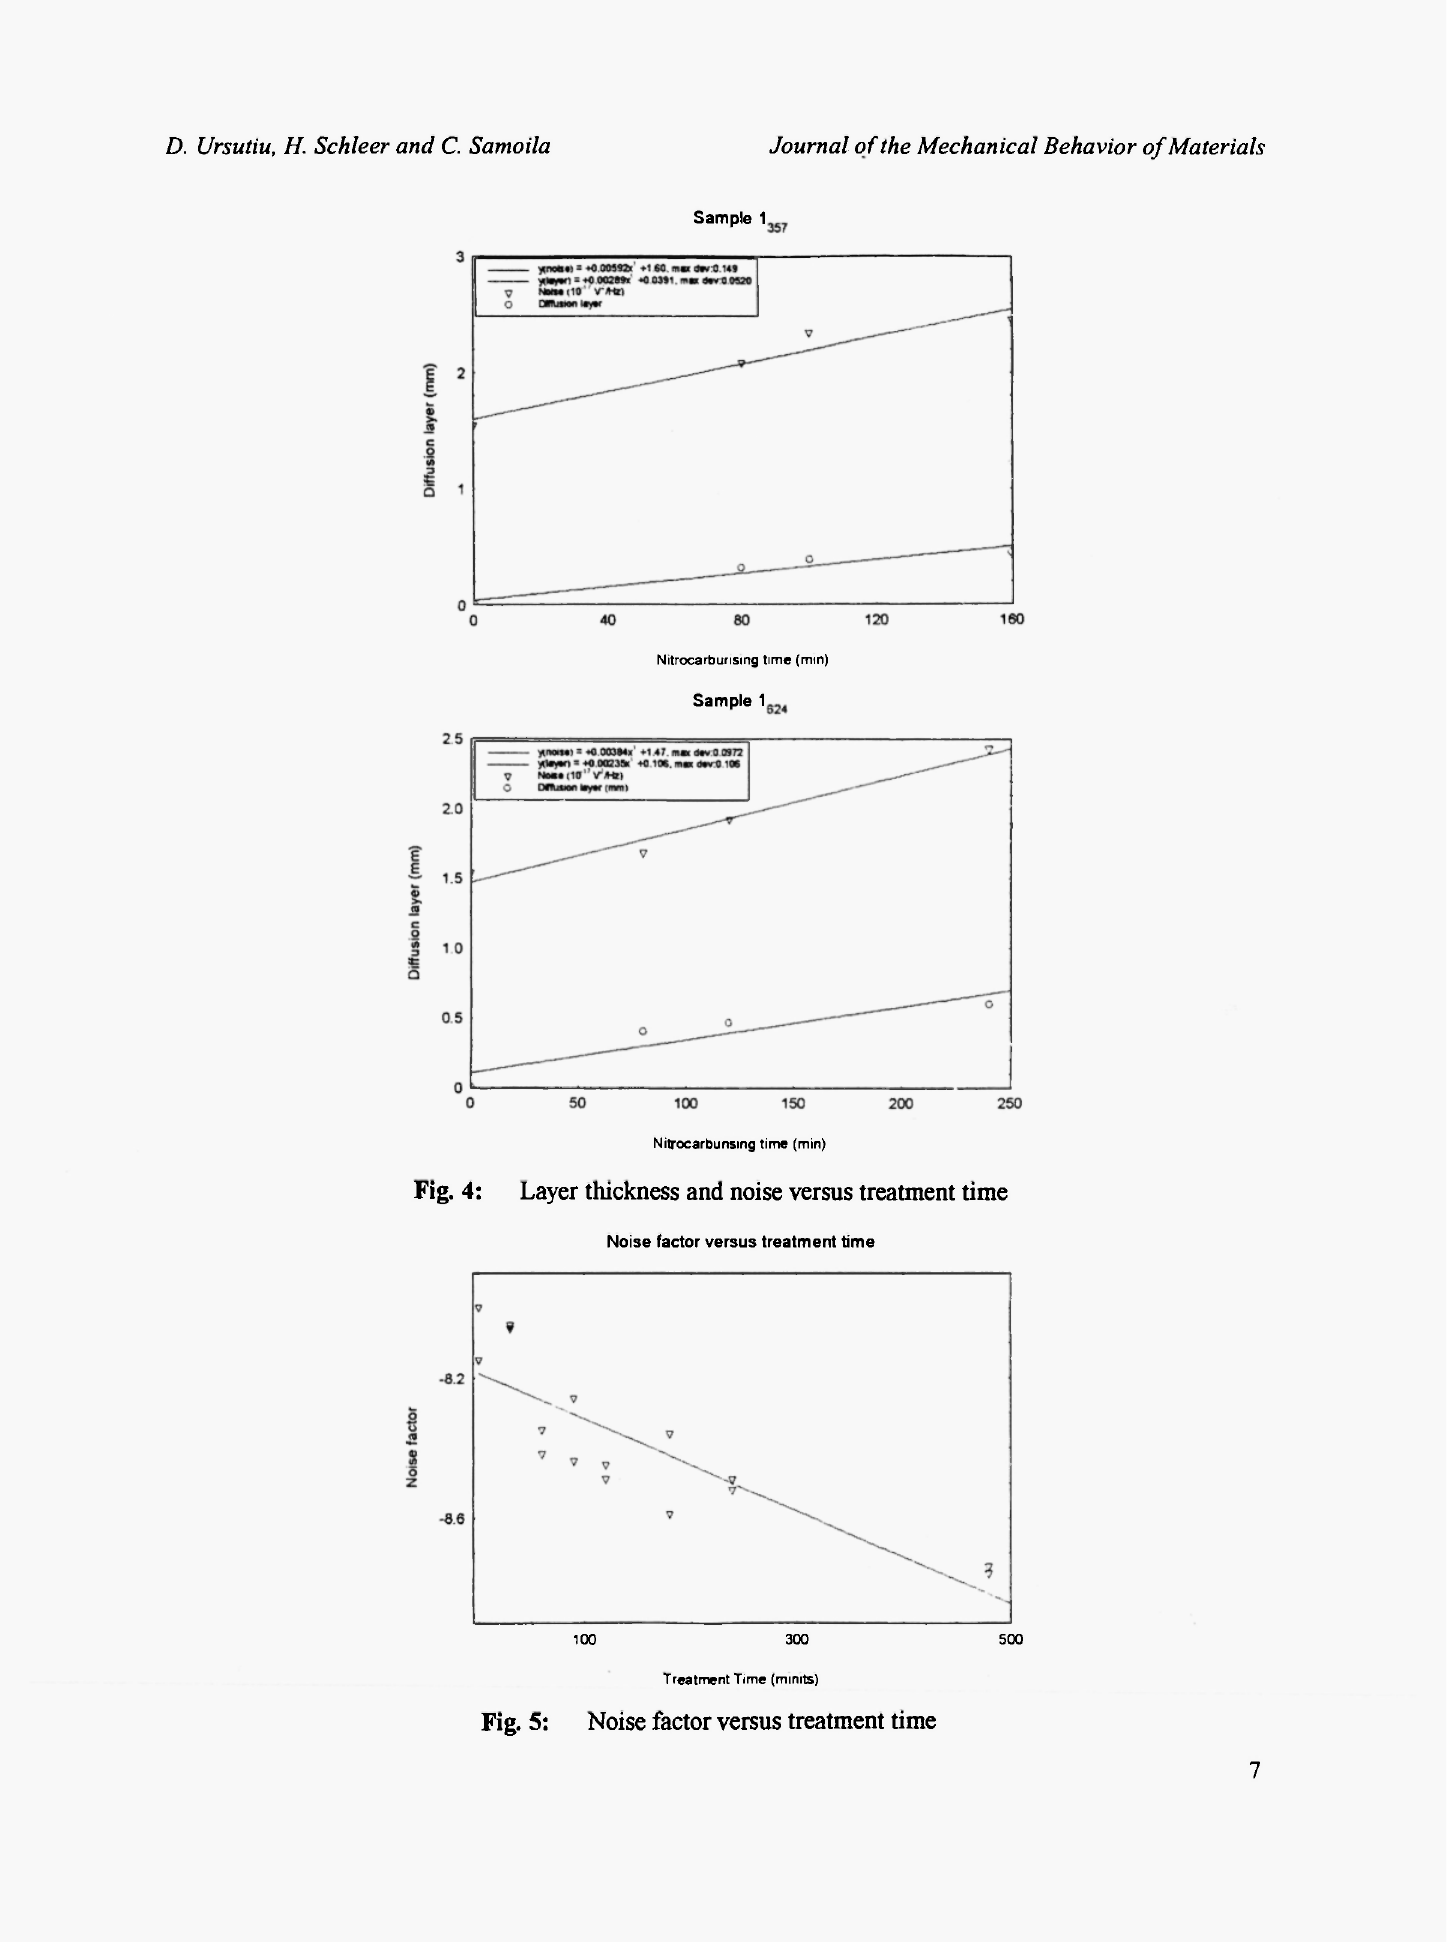
Fig. 5: Noise factor versus treatment